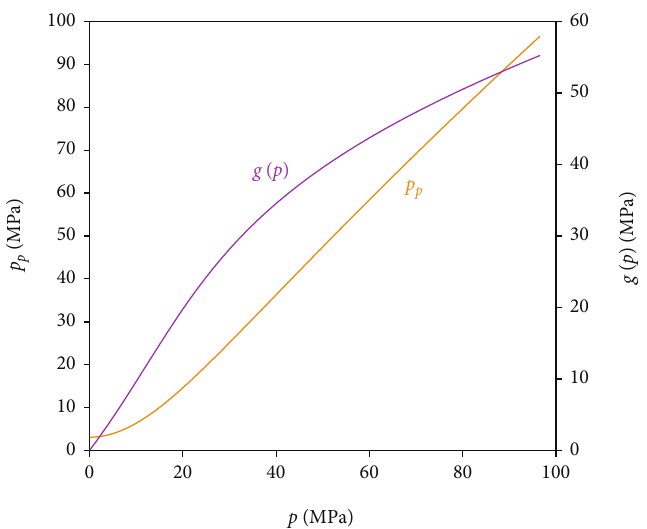
Figure 19: The relation curves of pseudopressure ( p